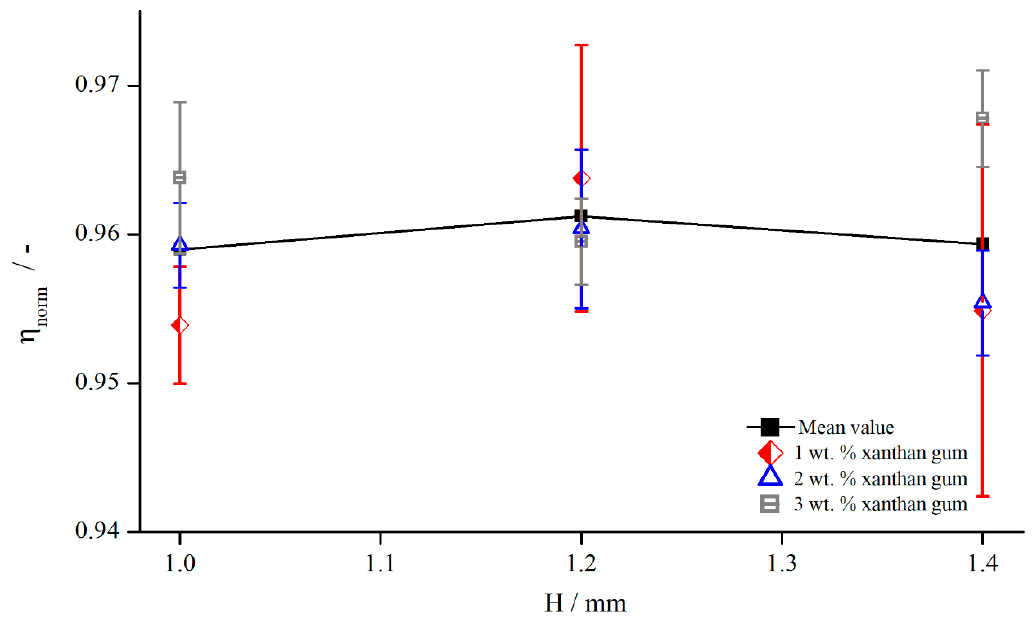
. γ . γ in the velocity profile a and true shear rate . γ = 5.05